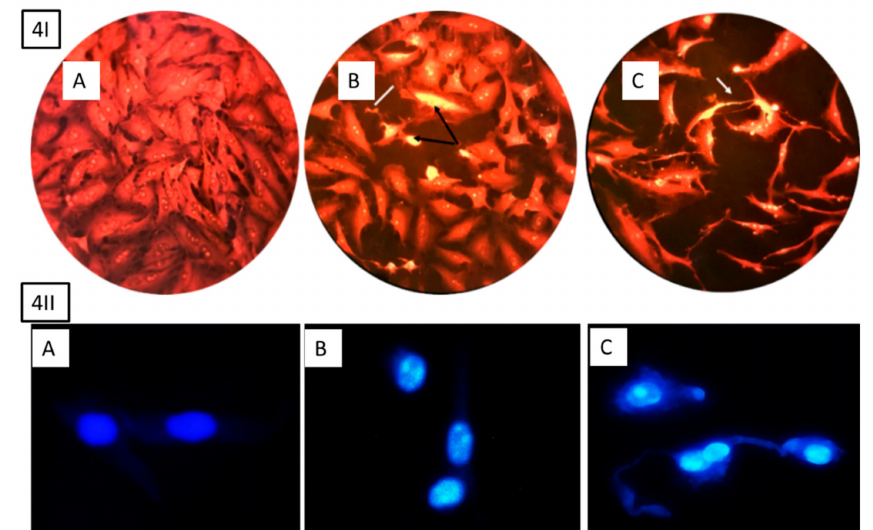
Figure 4. Morphological apoptosis of MCF-7 cells after treatment with hesperidin, 4I stained with sulforhodamine 101 and 4II cells stained with DAPI (20 and 40 µ g ml − 1 ). ( A ) Control cell has normal angular or polygonal shape with tact nucleus and is stained with a less bright fluorescence. ( B ) Treated cells with 20 µ g ml − 1 depict shrunken and condensed cytoplasm, chromatin (black arrow 4I), fragmentation, and apoptotic bodies (white line 4I). ( C ) Treated cells with 40 µ g ml − 1 clearly indicate late apoptosis including high cytoplasm and chromatin condensation, reduced cell count, and echinoid spikes on the surface of apoptotic cell (white arrow